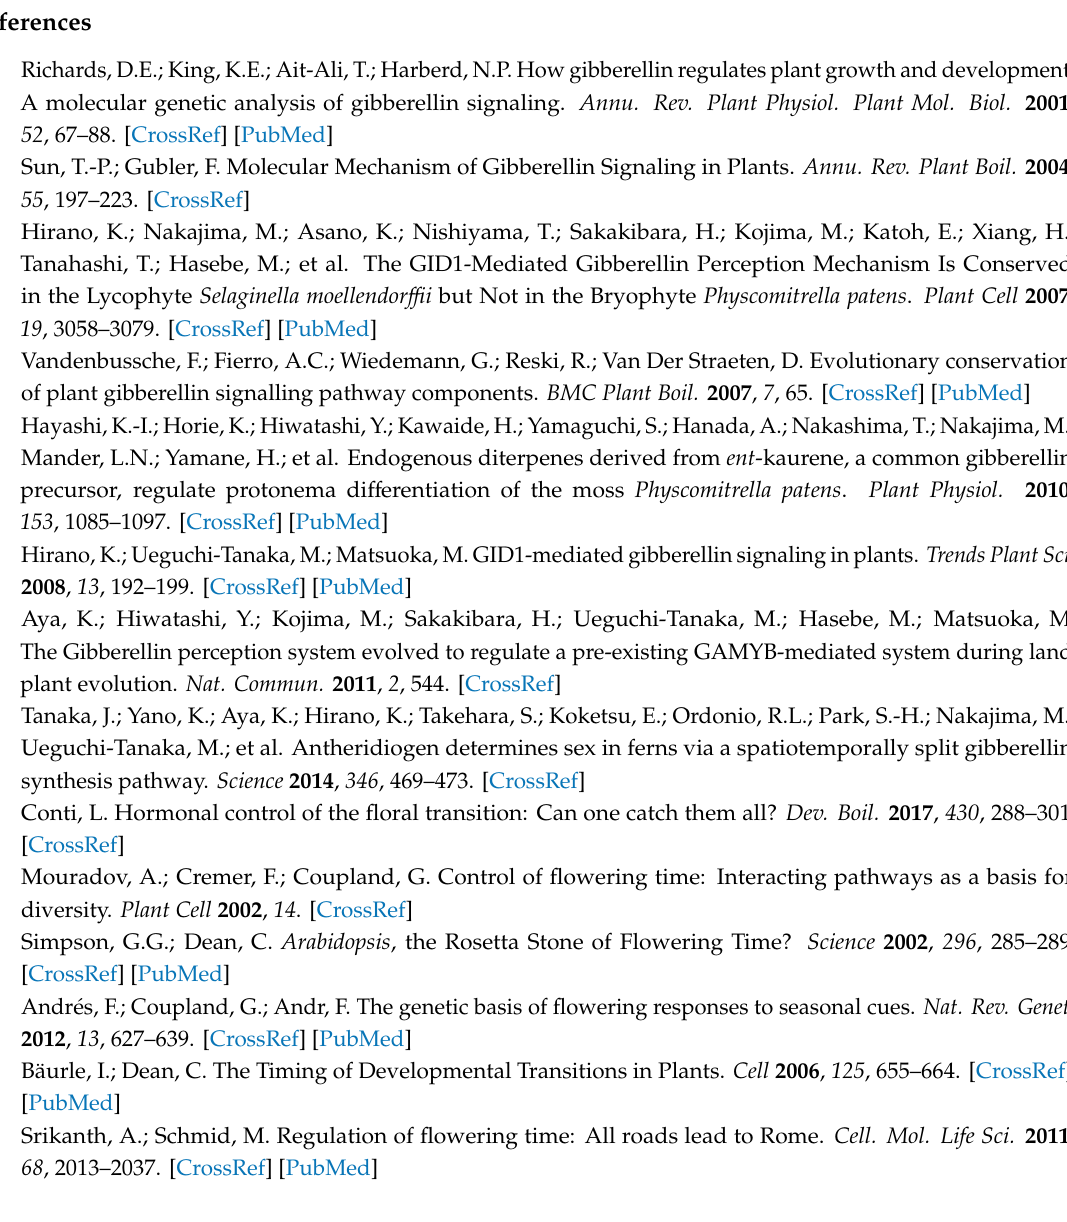
Figure S1: Sampling scheme of this study, Figure S2: The heat map analysis associated with GA signal transduction pathways, Figure S3: The heat map of reCj22492 , Table S1: The list of DEGs, Table S2: Results of enrichment analysis using